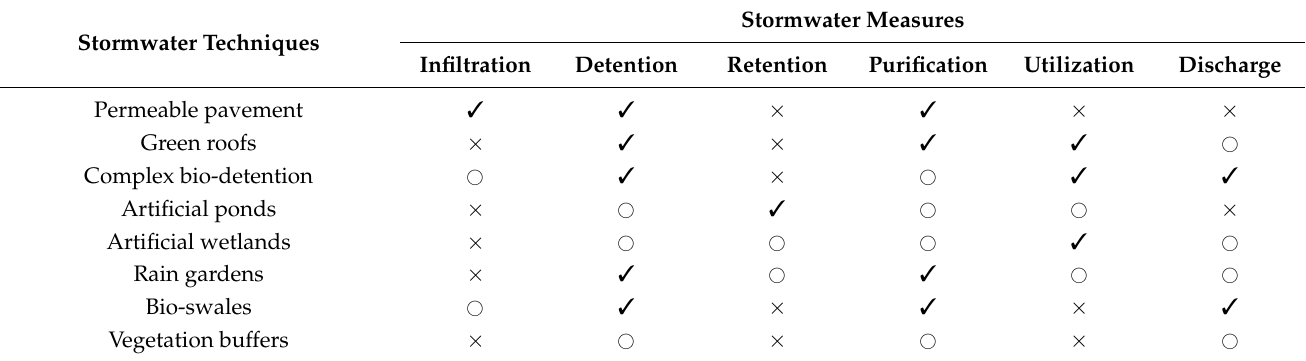
Table 2. Stormwater techniques and the associated stormwater